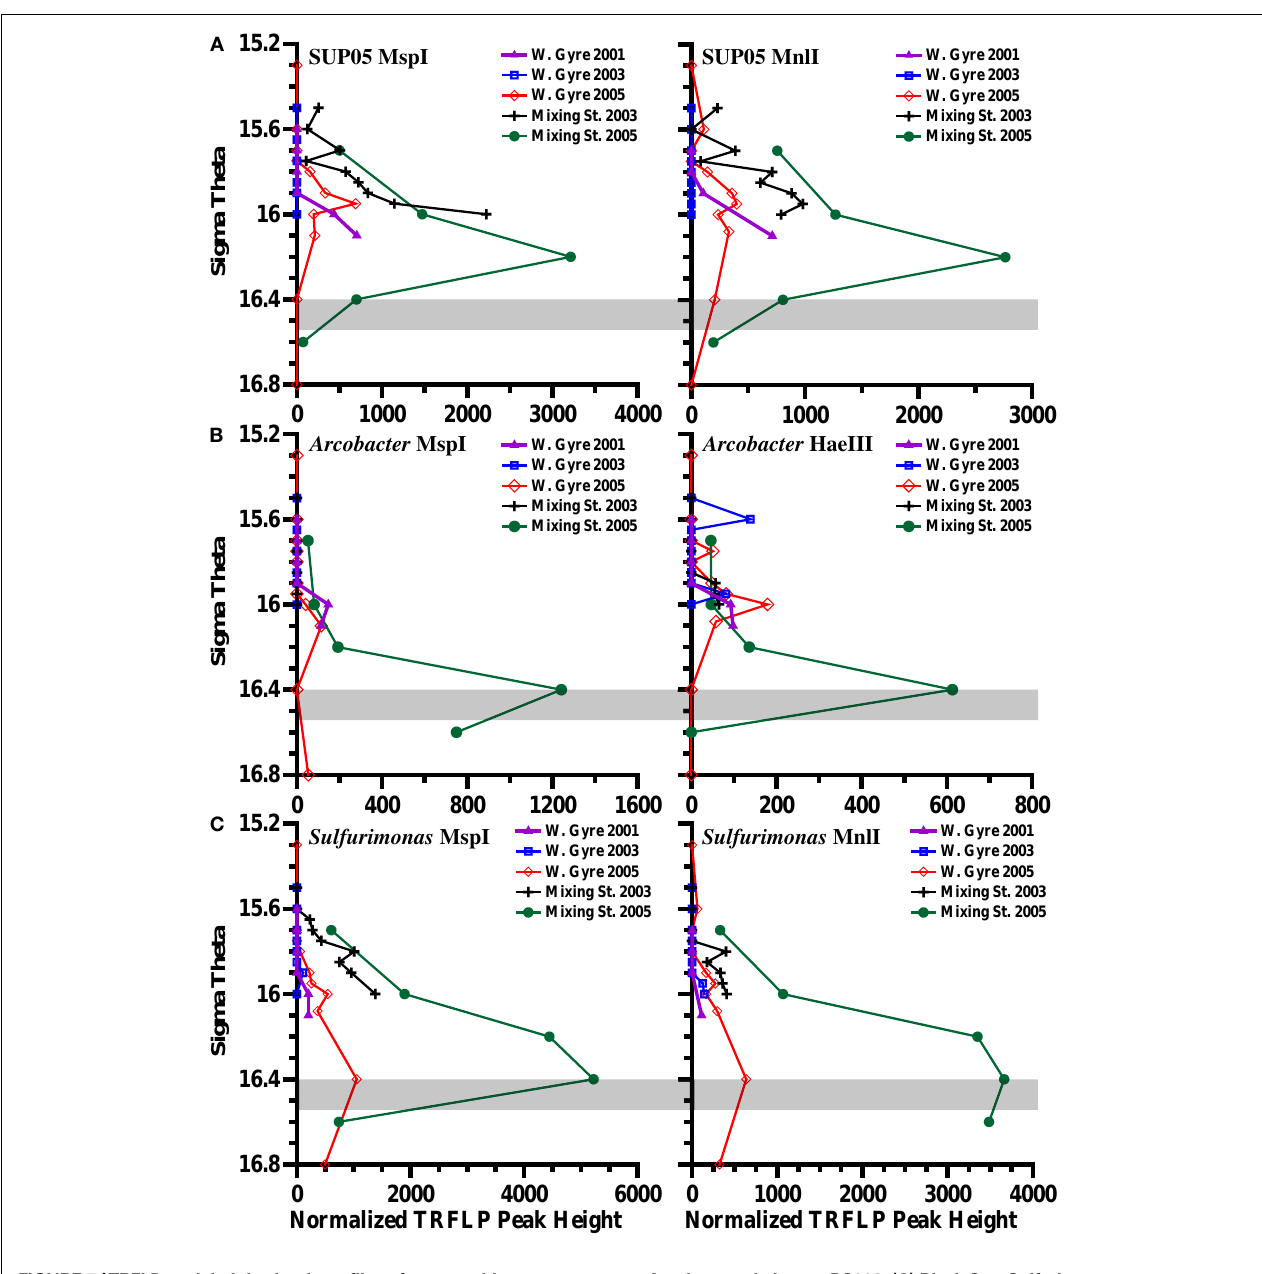
FIGURE 7 |TRFLP peak height depth profiles of autotrophic denitrification candidates that are enriched at the mixing zone station in 2005, obtained using multiple restriction enzymes, for the five stations: (A) Black Sea SUP05 phylotype BS077, (B)